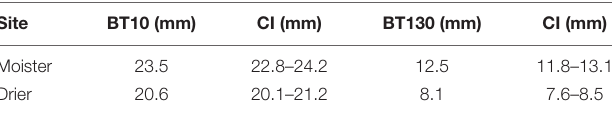
TABLE 4 | Minimum, mean and maximum absolute bark thickness at basal (BT10) and breast heights (BT130) with confidence intervals (CI) for each test site ( n = 512